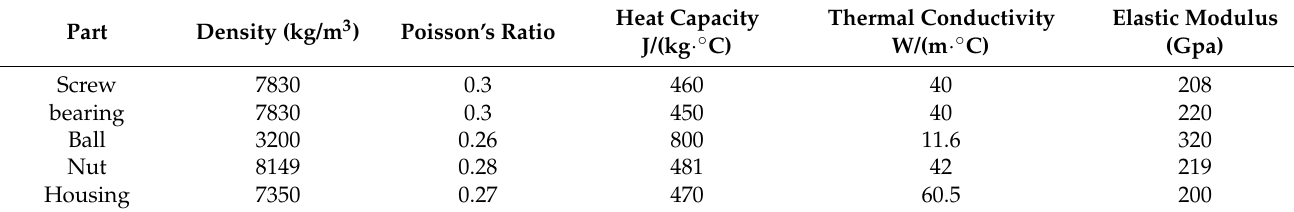
Table 2. Material properties of components.